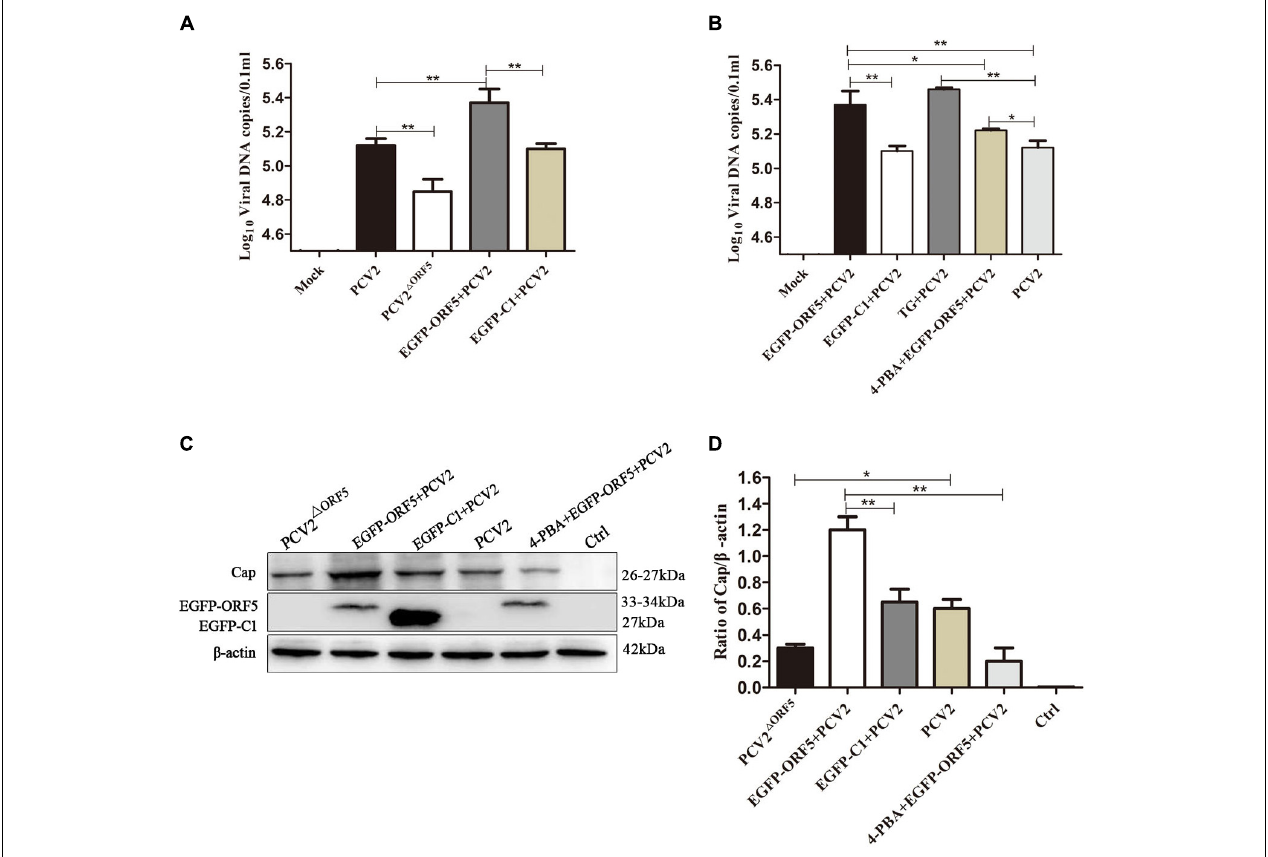
FIGURE 7 | ORF5 protein promotes replication of PCV2. (A) PK-15 cells were transfected with EGFP-ORF5 for 12 h and then infected with PCV2 for 36 h. PCV2 DNA copies were quantified by quantitative PCR. (B) PK-15 cells were pretreated with TG or 4-PBA for 2 h and then transfected with EGFP-ORF5 or infected with PCV2 for 36 h. DNA copies were quantified by quantitative PCR. (C) PK-15 cells were pretreated with 4-PBA for 2 h and then transfected with EGFP-ORF5 for 12 h and then infected with PCV2. At 36 h post-infection, Cap protein and GFP protein were detected by immunoblotting. (D) T -test on the grayscale analysis of the (C) , the ratio of Cap to β -actin. * p < 0.05, ** p <